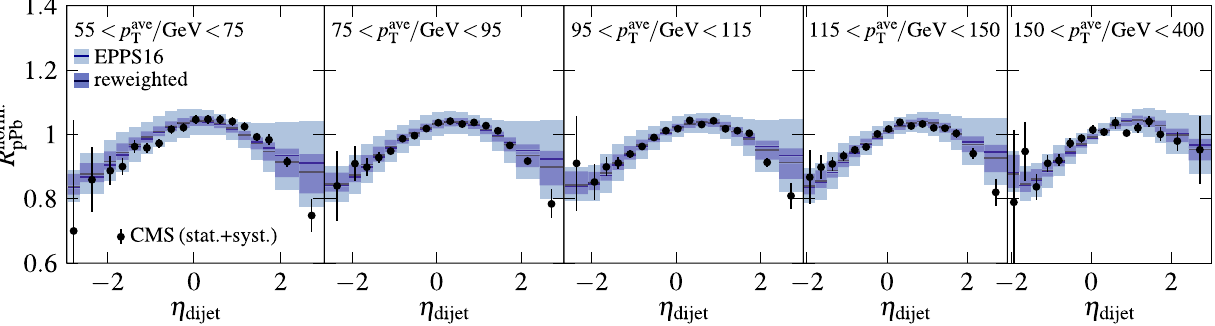
Fig. 10 The impact of reweighting on EPPS16 predictions of the nuclear modification ratio of the dijet spectra. The original predictions are shown with solid blue lines and light blue boxes representing the